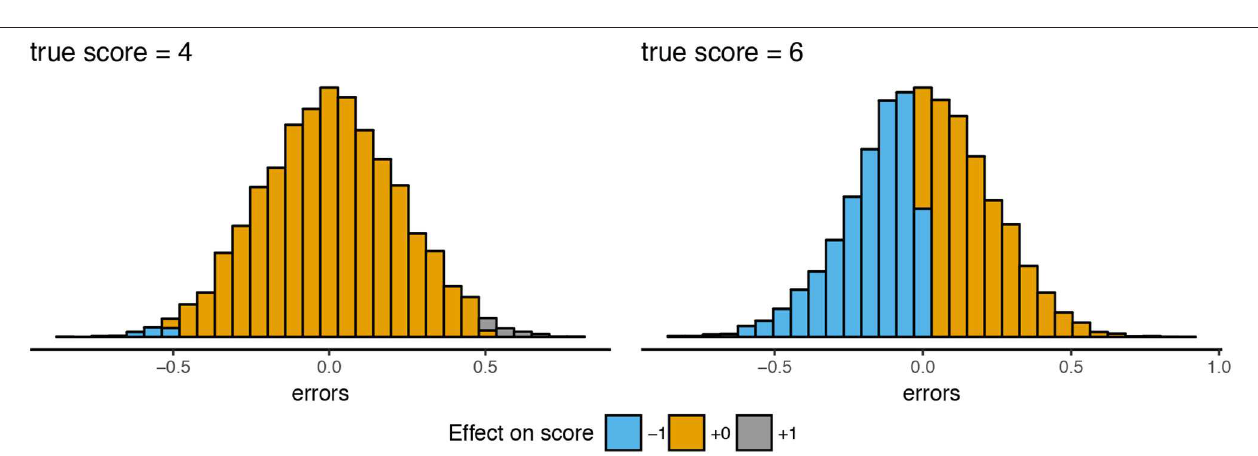
FIGURE 8 | Error score distribution for the first parallel test and the effect on the parallel test score for the two examinees of Figure 7 .